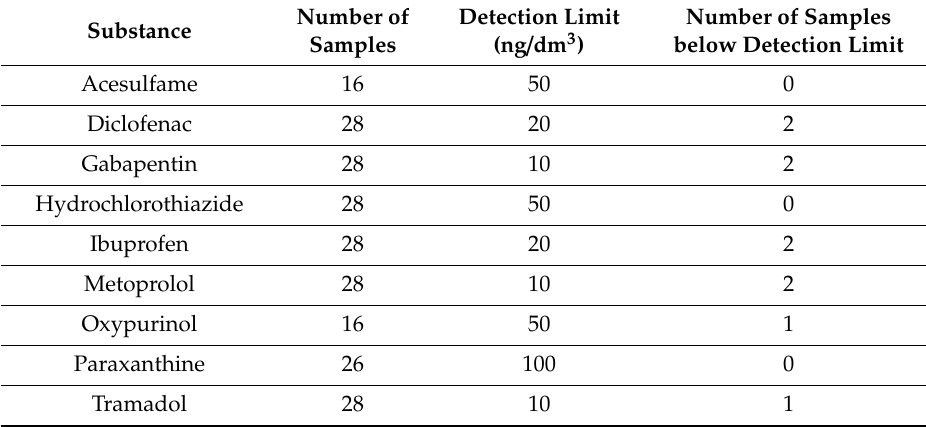
Table 3. Hnevkovice Profile—number of